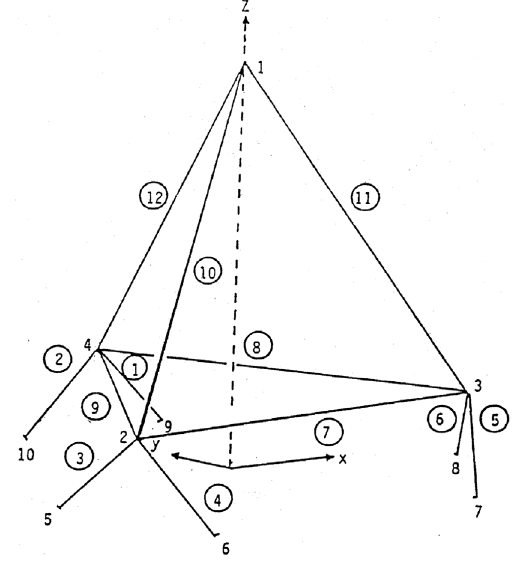
Fig. 2. A flexible tetrahedral structure